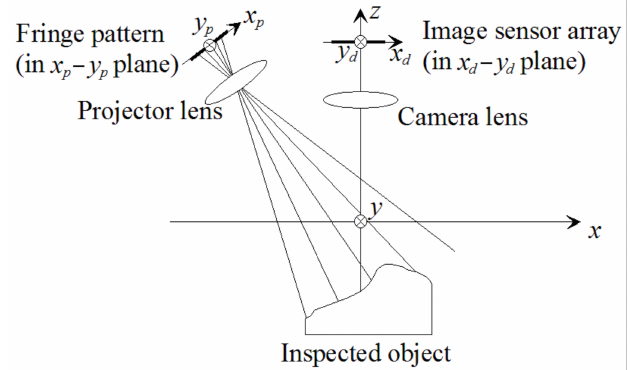
Figure 1. Optical configuration of phase-shifting fringe projection